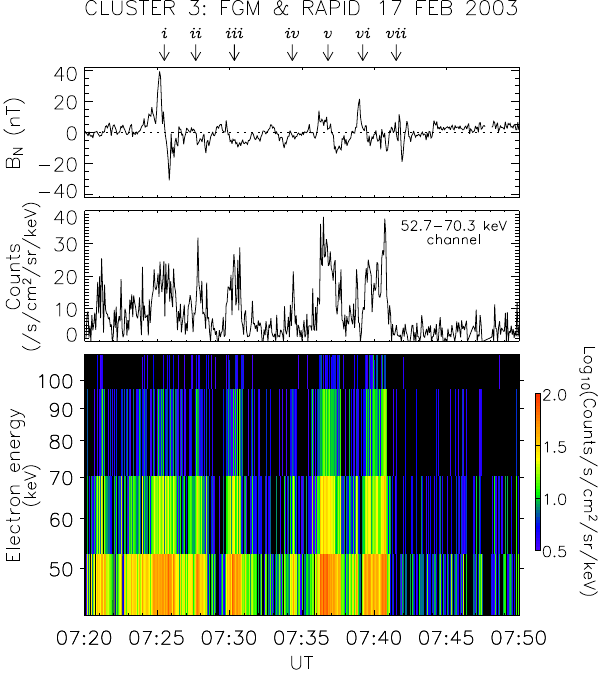
Fig. 4. Measurements of energetic electrons made by the RAPID IES instrument on board the Cluster 3 spacecraft during the interval 07:20–07:50 UT on 17 February 2003. The lower panel presents an energy-time spectrogram of omni-directional electron flux over the 40–110keV range, colour-coded as indicated. The centre panel presents a time-series in the 52.7–70.3keV range. For comparison, the upper panel shows the boundary-normal component of the mag- netic field observed at the same spacecraft (as presented in Fig.